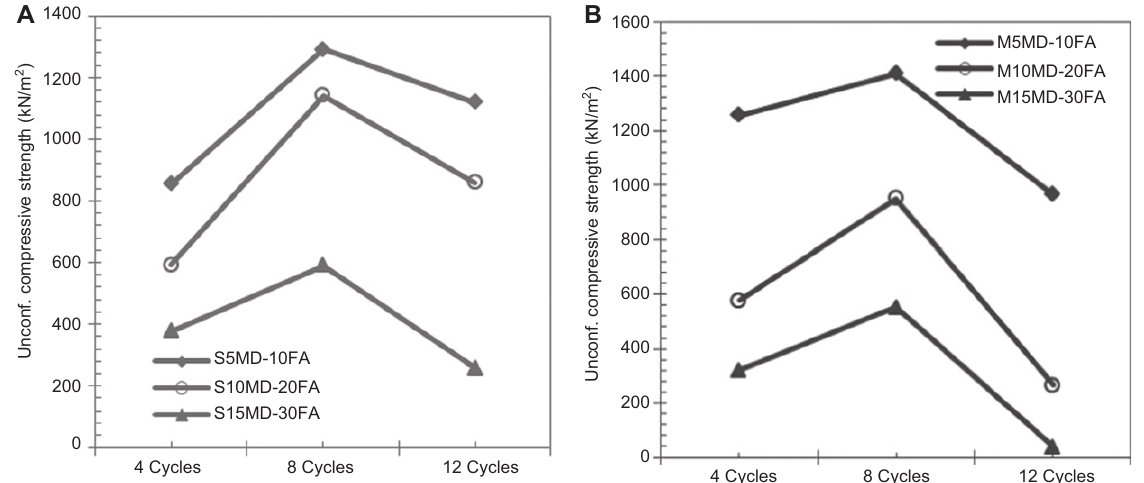
Figure 6 Influence of the cycle number to strength. (A) Specimens with SPE. (B) Specimens with MPE.